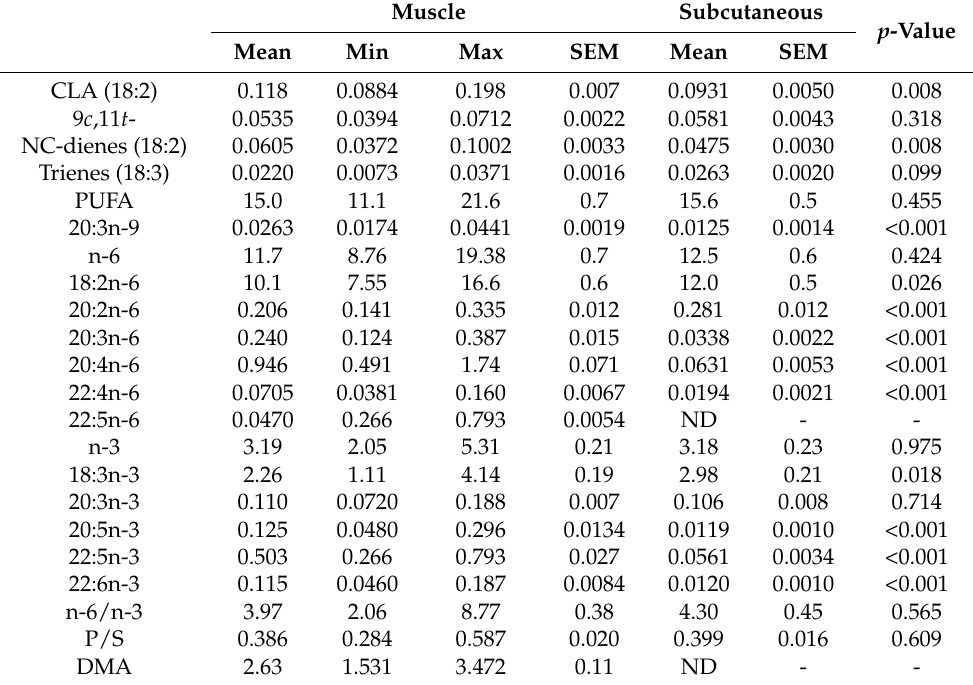
Table 4. Effect of fat tissue (muscle and subcutaneous fat) on the conjugated and non-conjugated diene, triene, polyunsaturated fatty acid and dimethylacetal composition of horse meat in percentage basis (%) ( n =